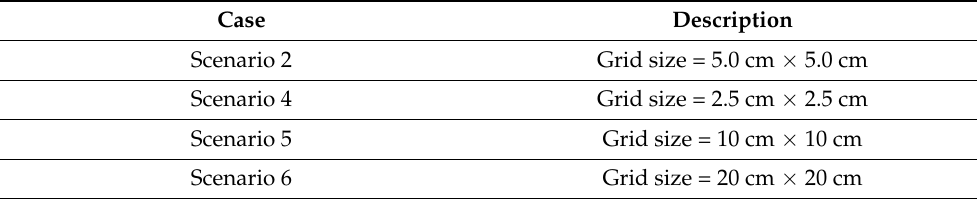
Figure 7. Cumulative oil production of scenarios 2, 4, 5 and 6 under varying reservoir model grids. Table 3. Summary of scenarios for grid size